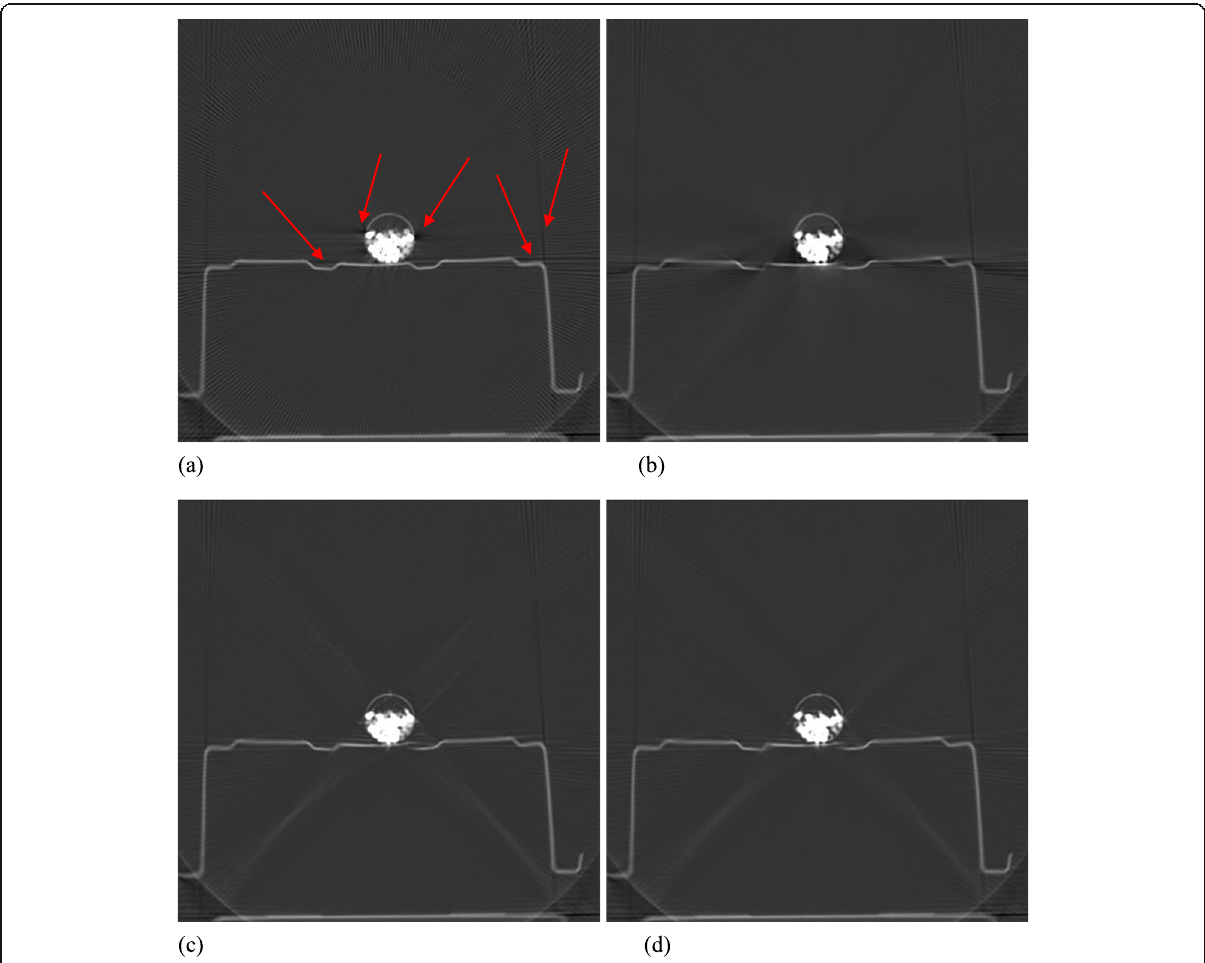
Fig. 5 Reconstruction of bag #5. a Raw FBP; b TV-term only; c Non-negativity-term only; d Combined. Some artifacts are marked by the red